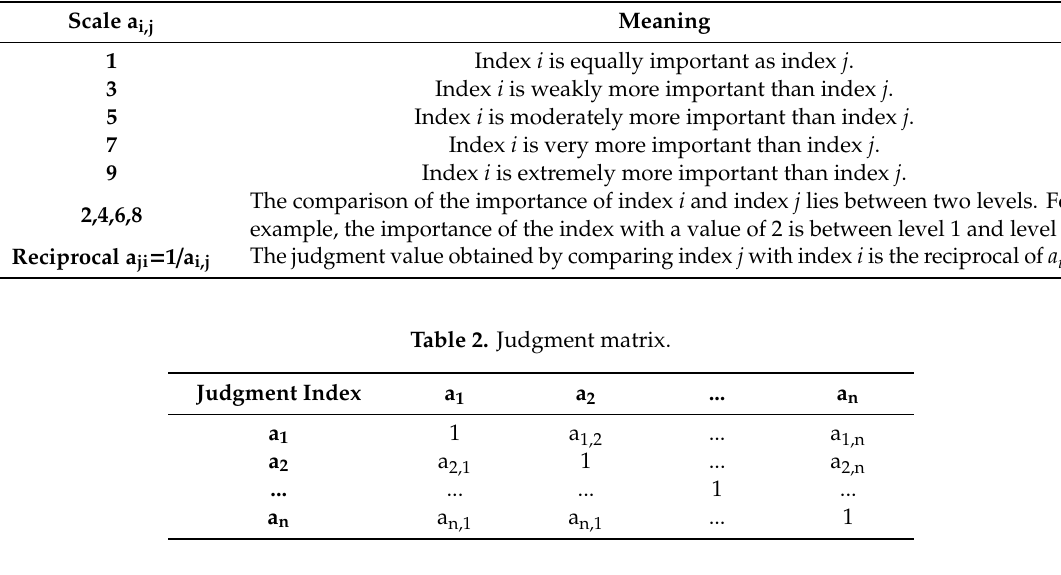
Figure 2. Overall Methodological Framework. TOPSIS = Technique for Order of Preference by Similarity to an Ideal Solution. Table 1. Meanings of 1–9 Index Scale of the Analytic Hierarchy Process (AHP) method.